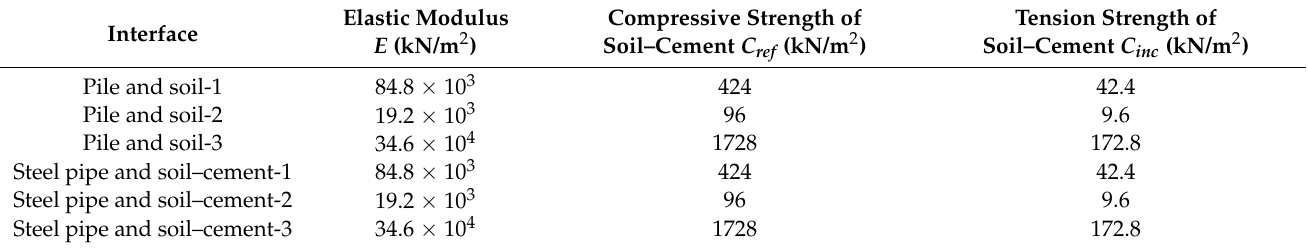
Table 2. Material parameters of FEM.